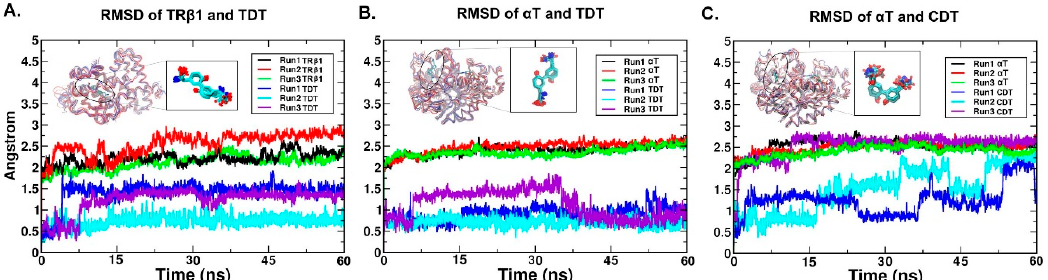
Figure 3. The RMSD of protein backbone atoms and heavy atoms of ligands along the production phase simulations. The RMSD of the protein backbone atoms and ligand atoms from TR β 1-TDT, α T-TDT and α T-CDT system are shown per panel ( A ), ( B ) and ( C ). Different replicates were displayed by the colour lines indicated in each legend box. The superposed proteins by tube were made by superposing 60 conformations (20 conformations per replicate) with 100 ps interval along the production phase. The degree of the dispersion of the tubes indicated the protein dynamics along simulation time series (‘red to blue ′ represents ‘0 ns to 60 ns ′ ). The ligands superposed with the same method were shown nearby and draw by sticks.